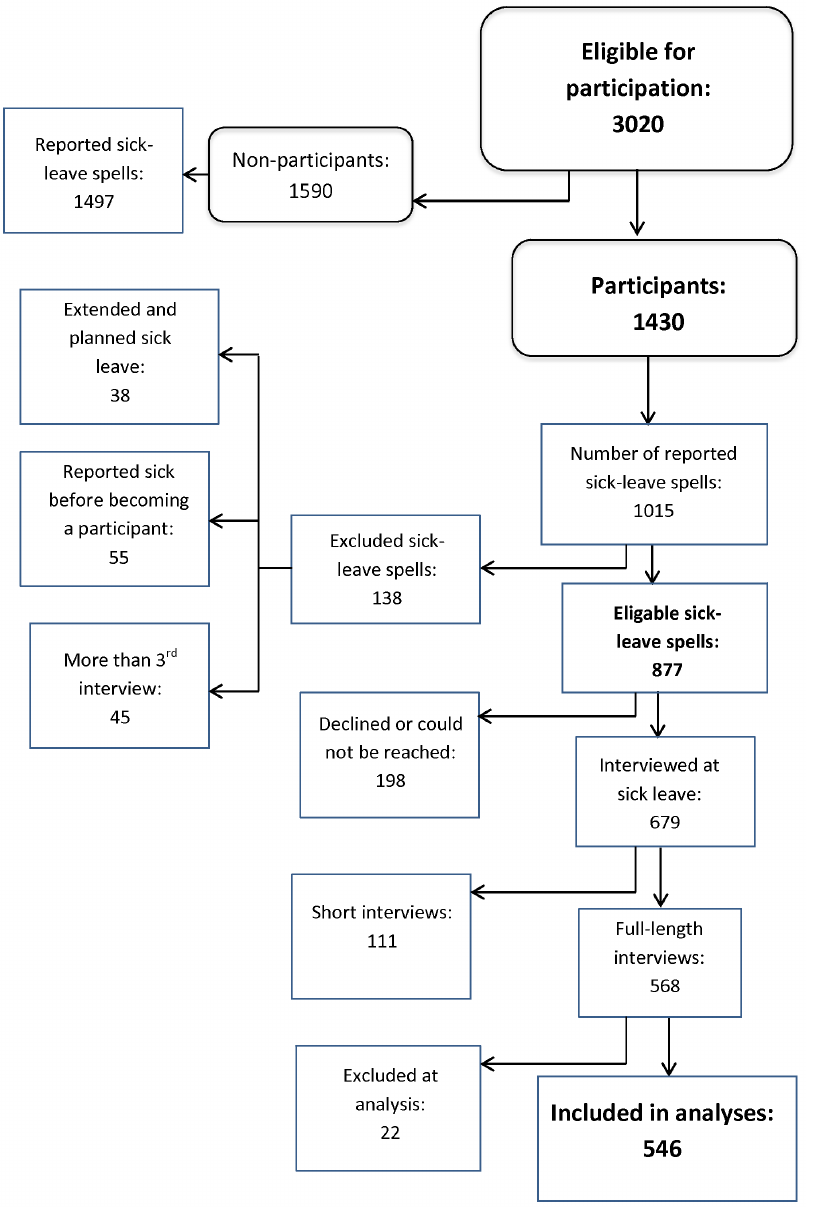
Figure 2. Flow chart of the data collection of sick-leave spells. Description of inclusion and exclusion of sick-leave spells in the present study, derived from the 1, 430 participants of a cohort study carried out at six Swedish workplaces between 2005 and